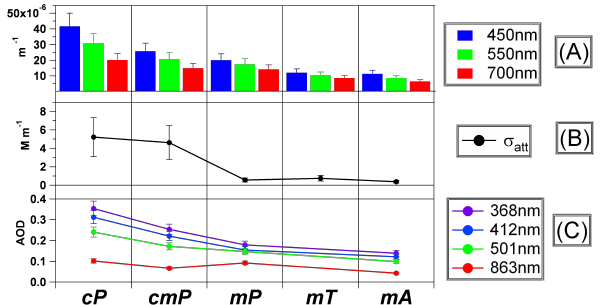
Fig. 15. (A) 450nm, 550nm, and 700nm scattering coefficient as a function of air mass categories, (B) absorption coefficient as a function of air mass categories. (C) Aerosol Optical Dept as a function of 368nm, 412nm, 501 and 863nm wavelengths and aor mass categoties.